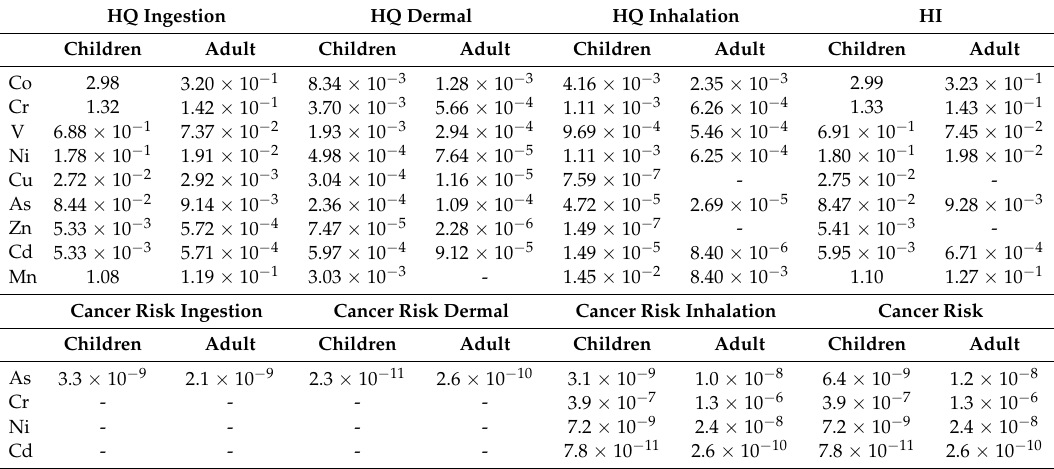
Table 4. Hazard quotient (HQ) values for various pathways and elements, hazard indices (HIs), and cancer risk resulting from exposure to soil elements on Santiago Island. HQ Ingestion HQ Dermal